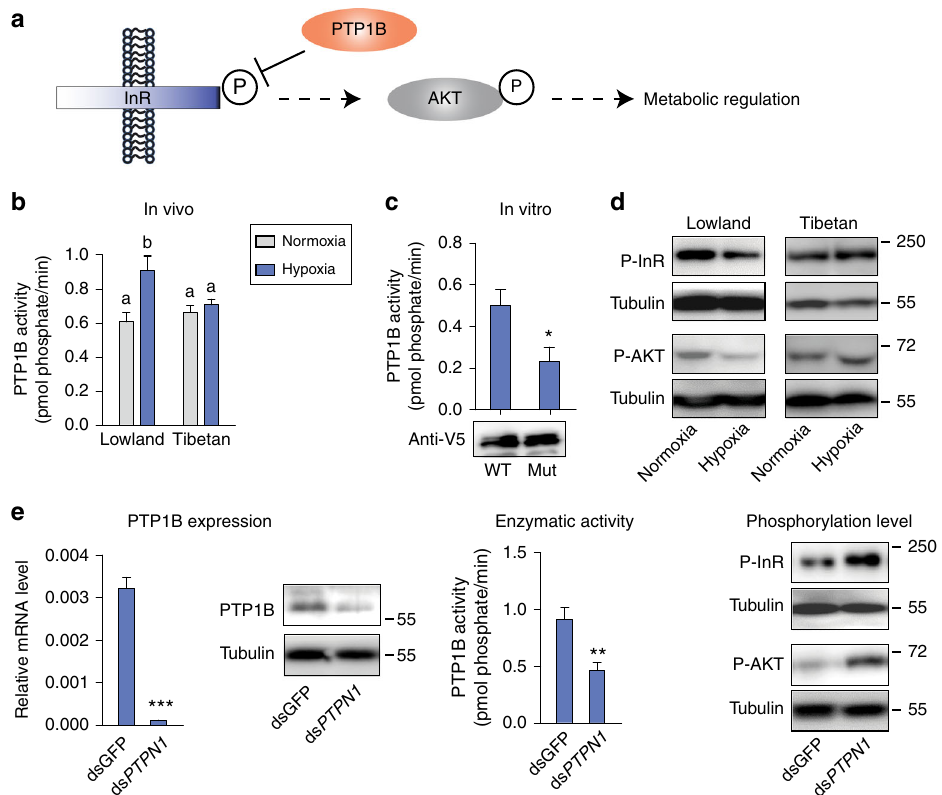
Fig. 4 Effect of PTPN1 mutation on the insulin signaling pathway. a Illustration of the insulin signaling pathway, in which PTP1B is a negative regulator of the pathway through the dephosphorylation of insulin receptor at its tyrosine site. b PTP1B enzyme activity differing between Tibetan and lowland locusts in response to hypoxia induction. Signi fi cant differences are denoted by different letters (one-way ANOVA, P < 0.05) ( n = 6 replicates). The values of the columns here and below are shown as mean ± standard error (s.e.m.). c The coding mutation altered PTP1B enzyme activity in vitro. The wild-type p. Asn349 (WT) and mutant-type p.Ile349 (Mut) PTP1B were overexpressed in S2 cells and induced by 1% hypoxia for 6 h. PTP1B production level was detected by western blot with anti-V5 tag antibody. * P < 0.05 by Student ’ s t -test. n = 3 replicates. Supplementary Fig. 15d shows the original image. d Western blot revealed decreased InR and AKT phosphorylation level after hypoxia induction in lowland locusts. P-InR and P-AKT represent phosphorylation of InR and AKT, respectively. The molecular weight markers are shown on the right side of the blot. Supplementary Figs. 15e – h show